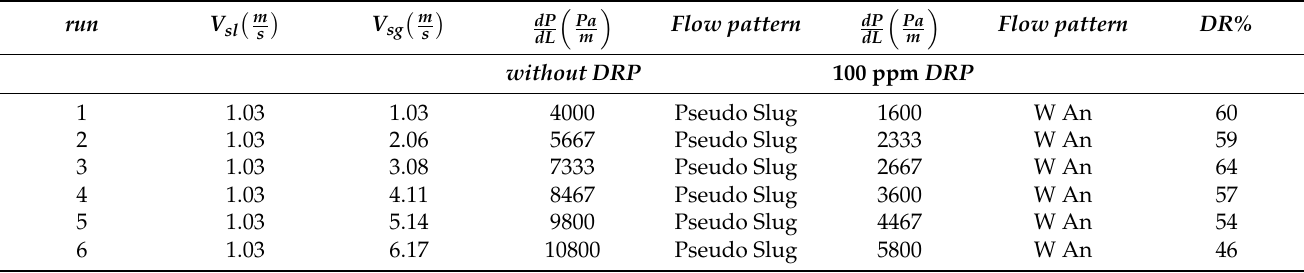
Table A5. Frictional Pressure Gradient and Transition of Pseudo Slug Flow Regime Using 100 ppm